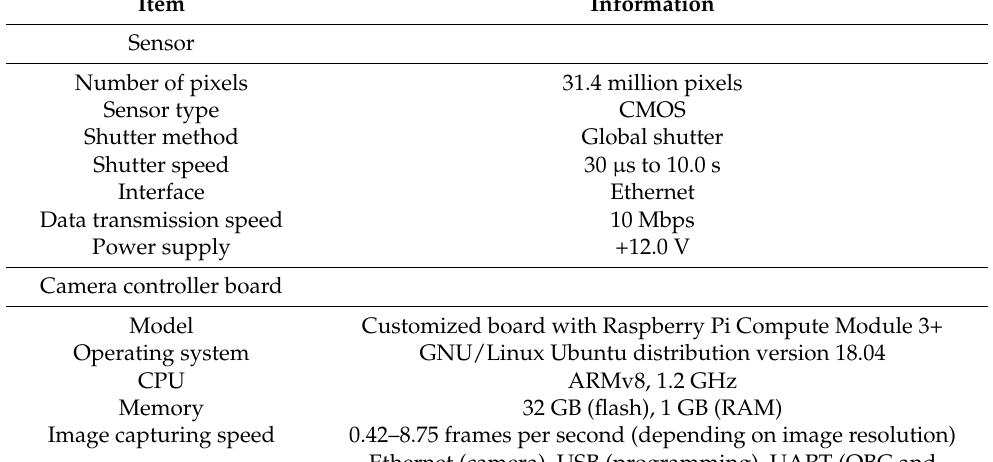
Table 1. Imaging payload properties.